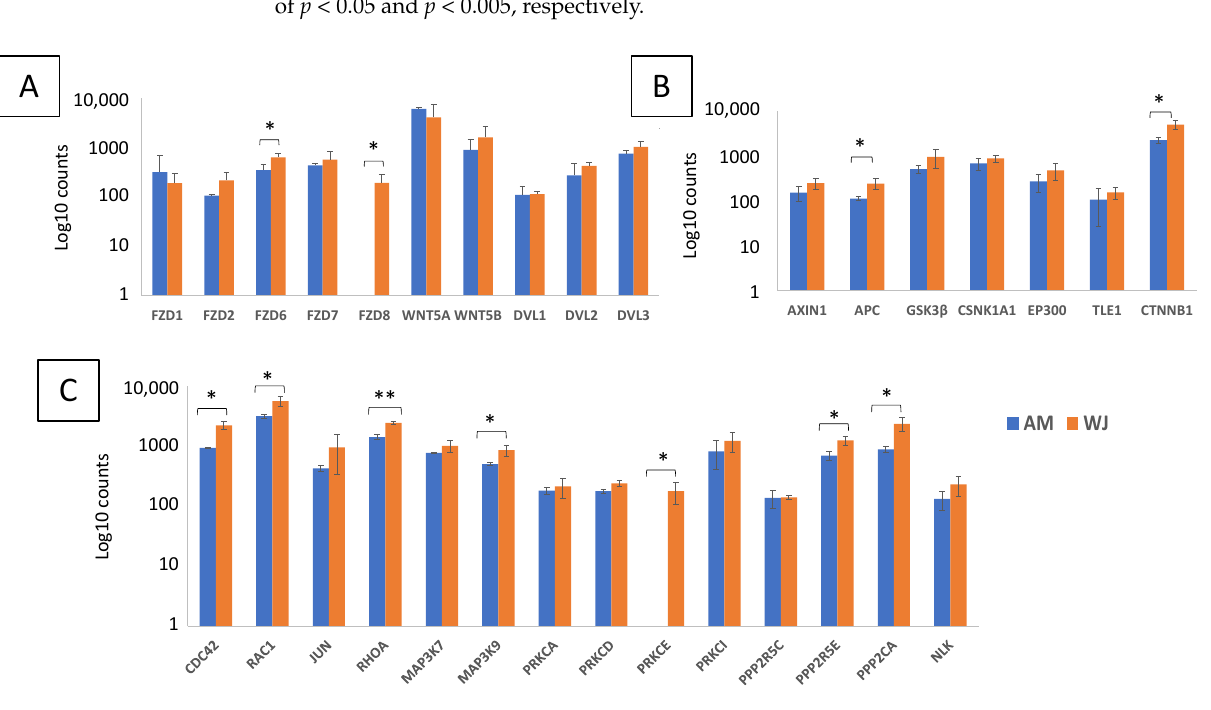
Figure 3. Wnt signalling pathway-related gene expression in AM- and WJ-MSCs under basal condition. ( A ) Genes encoding Wnt ligands and receptors, ( B ) genes encoding canonical Wnt pathway and ( C ) non-canonical Wnt pathway. Data represented mean counts ± SD. Asterisks (*) and (**) represent statistical significance of p < 0.05 and p < 0.005, respectively.